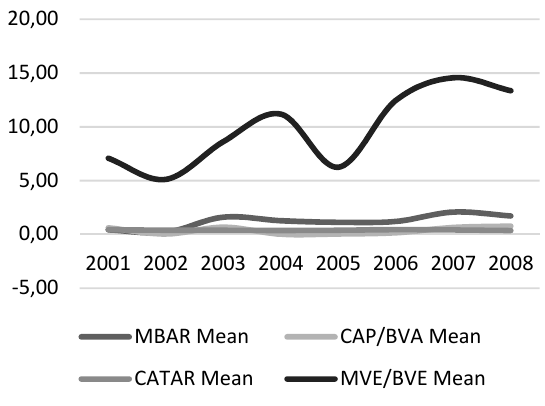
Figure 3. Development of Average. Average Value Indicators of Investment Decision in Property and